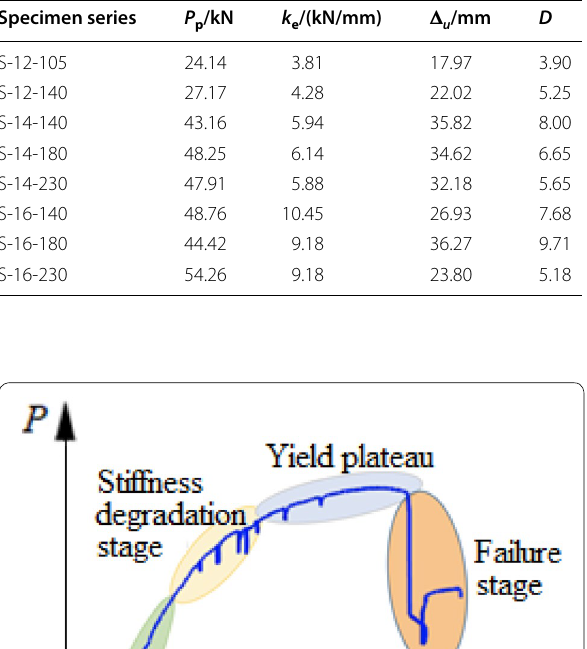
Table 3 Main mechanical property parameters Specimen series